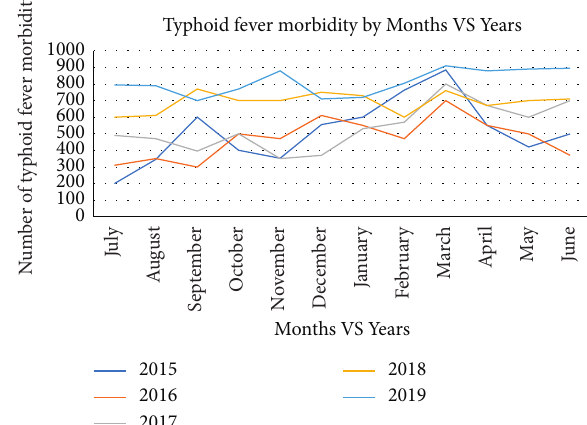
Figure 4: Trends of typhoid fever by months in the Jimma Zone, Oromia Region, Southwest Ethiopia, from 2015 to